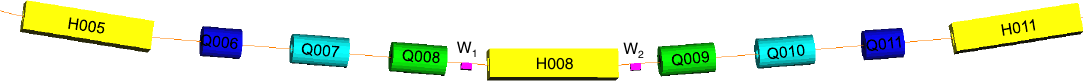
FIG. 8. Top view of the horizontal bend string along the M5 line. The yellow rectangular shaped elements are dipoles; the green, blue, and cyan cylinders are quadrupoles; and the magenta elements, which are labeled as W 1 and W 2 , are the ð C 2 H 4 Þ n absorbers. Both wedges are house shaped, 80 mm in height, 125 mm thick, and have an angle of 162º. All three dipoles are 1524 mm